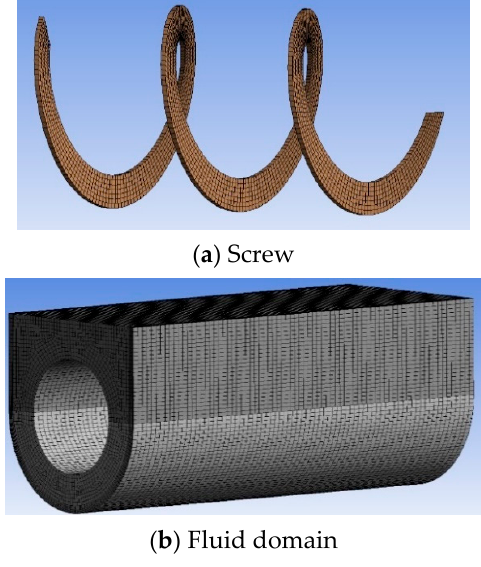
Figure 7. Generation of mesh.